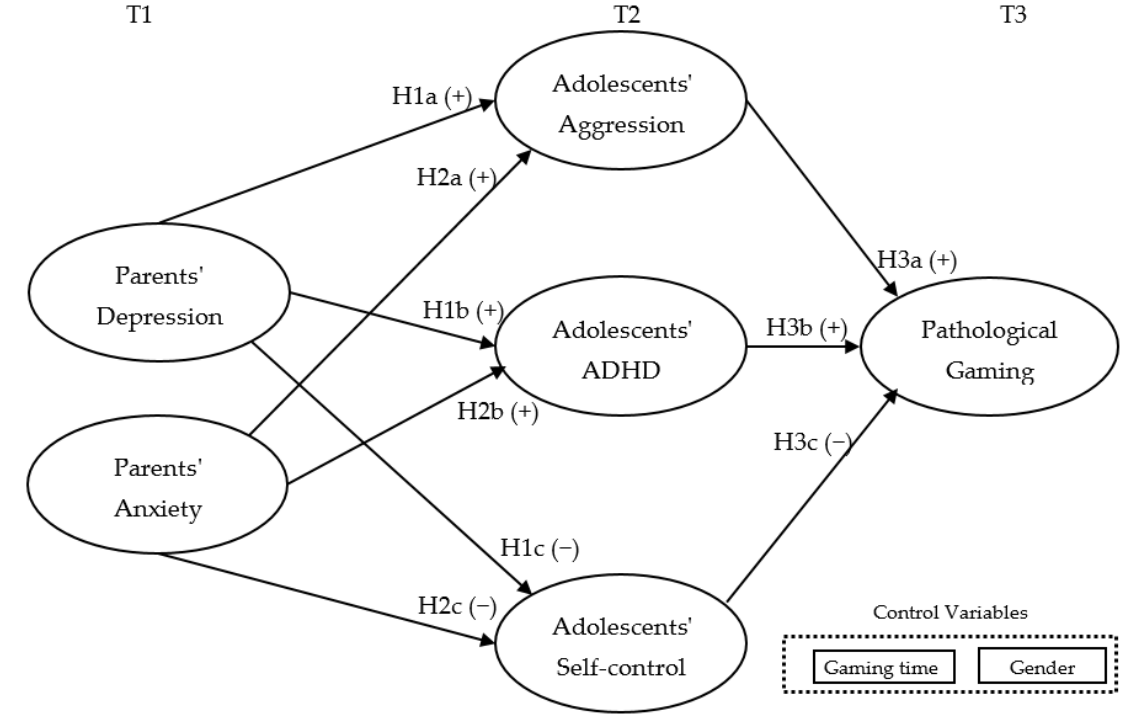
Figure 1. Research